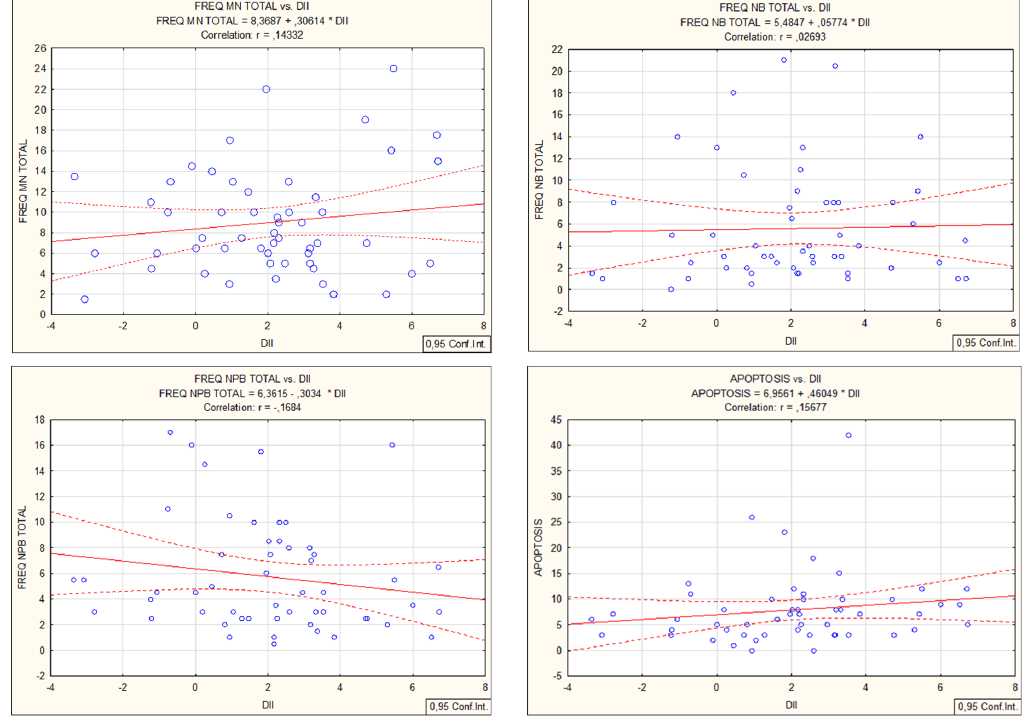
Figure 1. Spearman correlations of MN—micronuclei, NB—nuclear buds, NPB—nucleoplasmic bridges and apoptosis in micronucleus cytome assay with inflammatory food index DII.